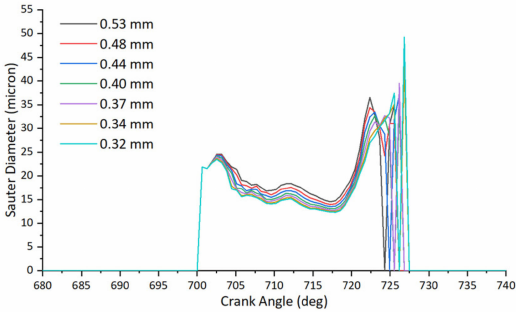
Figure 23. Fuel SMD under varied nozzle